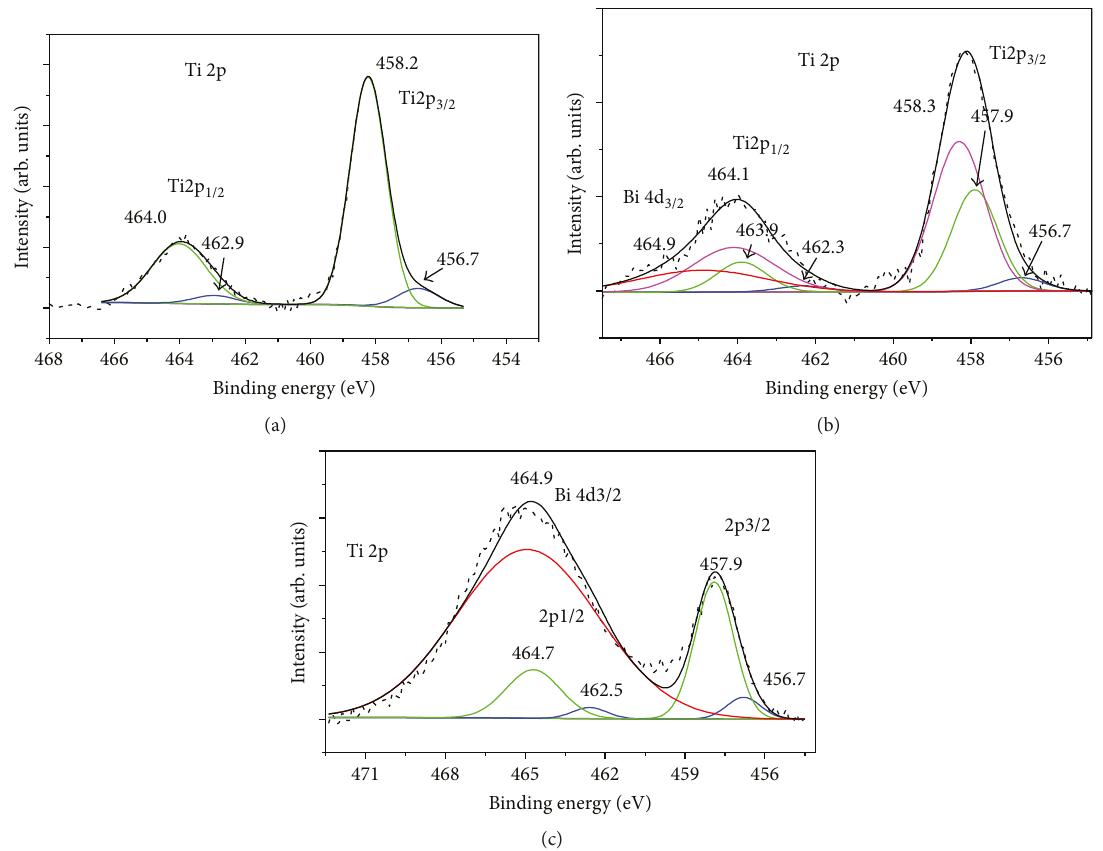
Figure 5: Gaussian deconvolution of the XPS spectra, Ti 2p region (a) 0 at. %, (b) 10.4at. %, and (c) 25.4 at. % of bismuth.